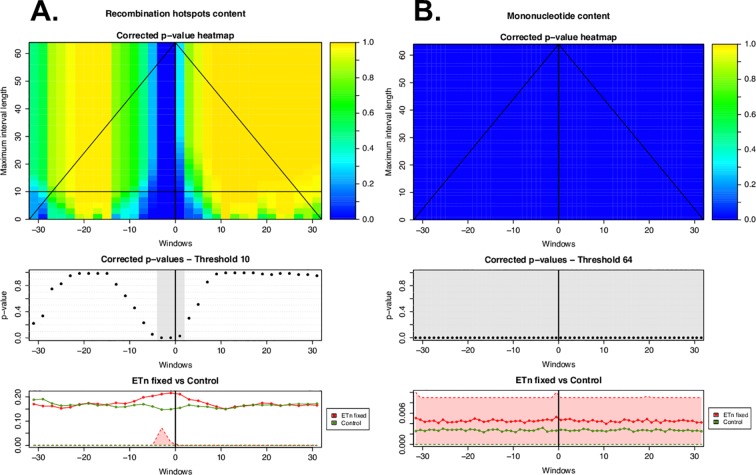
ITP results using the mean difference as test statistics for (A) recombination hotspots (localized differential landscape–LDL) and (B) mononucleotide microsatellites (invariant differential landscape–IDL) in the flanking regions of fixed ETn vs. controls. The heatmap in the top panel shows the p-values for each component (i.e. window; horizontal axis) corrected controlling the family-wise error rate on all possible maximum interval lengths (vertical axis). Blue corresponds to low p-values, hence significant differences between the distributions underlying the flanking regions of ERVs and the controls. The middle panel shows corrected p-values at the chosen maximum interval length threshold, with gray highlighting significant components (corrected p-values<0.05). The lower panels show the average of the genome feature under consideration over the flanking regions of all fixed ETns (red line) and controls (green line). First and third quartiles (25% and 75% quantiles) are shaded in the respective colors–red for ETns and green for controls. The shades for control are invisible because they are zeros for control. The heatmap suggests the scales (vertical axis) and the locations (horizontal axis) at which the feature is significant to characterize ERVs genomic landscape.